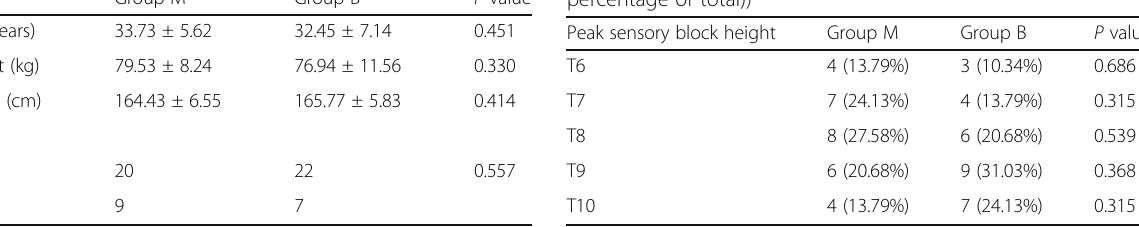
Table 3 Peak sensory block height achieved in both groups (data are presented as number of patients (with